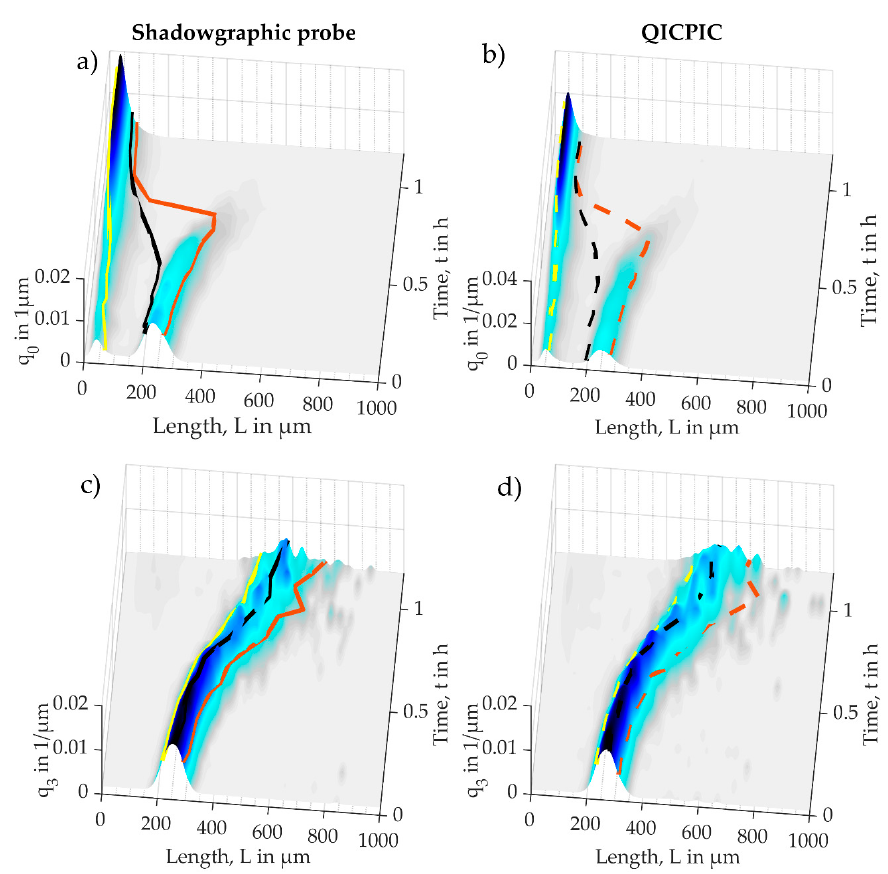
Figure A1. Exp. 1—KH 2 PO 4 distributions ( a ) q 0 -distribution shadowgraphic probe; ( b ) q 0 -distribution QICPIC; ( c ) q 3 -distribution shadowgraphic probe; ( d ) q 3 -distribution QICPIC. Solid lines —percentiles of the shadowgraphic probe; Dashed lines —percentiles of the QICPIC; yellow and red − 0.15 and 0.85 percentile distribution; blue —transient mean sizes of the distribution. Crystals 2020 , 10 , x FOR PEER REVIEW